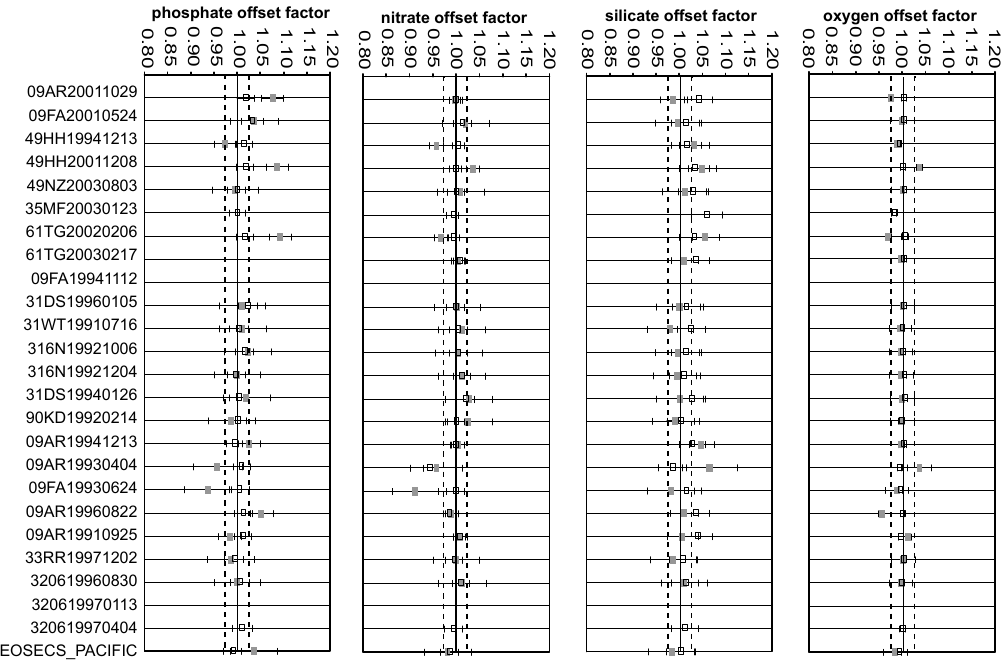
Figure 4. Results of initial inversion (grey boxes) of crossover results and for the final inversion after cruise adjustments were made (black squares) for those parameters with multiplicative corrections. Error bars indicate one standard deviation of the inverted o ff set. The dashed lines indicate the minimum o ff sets required for an adjustment to be proposed (2% for nutrients and 1% for oxygen).